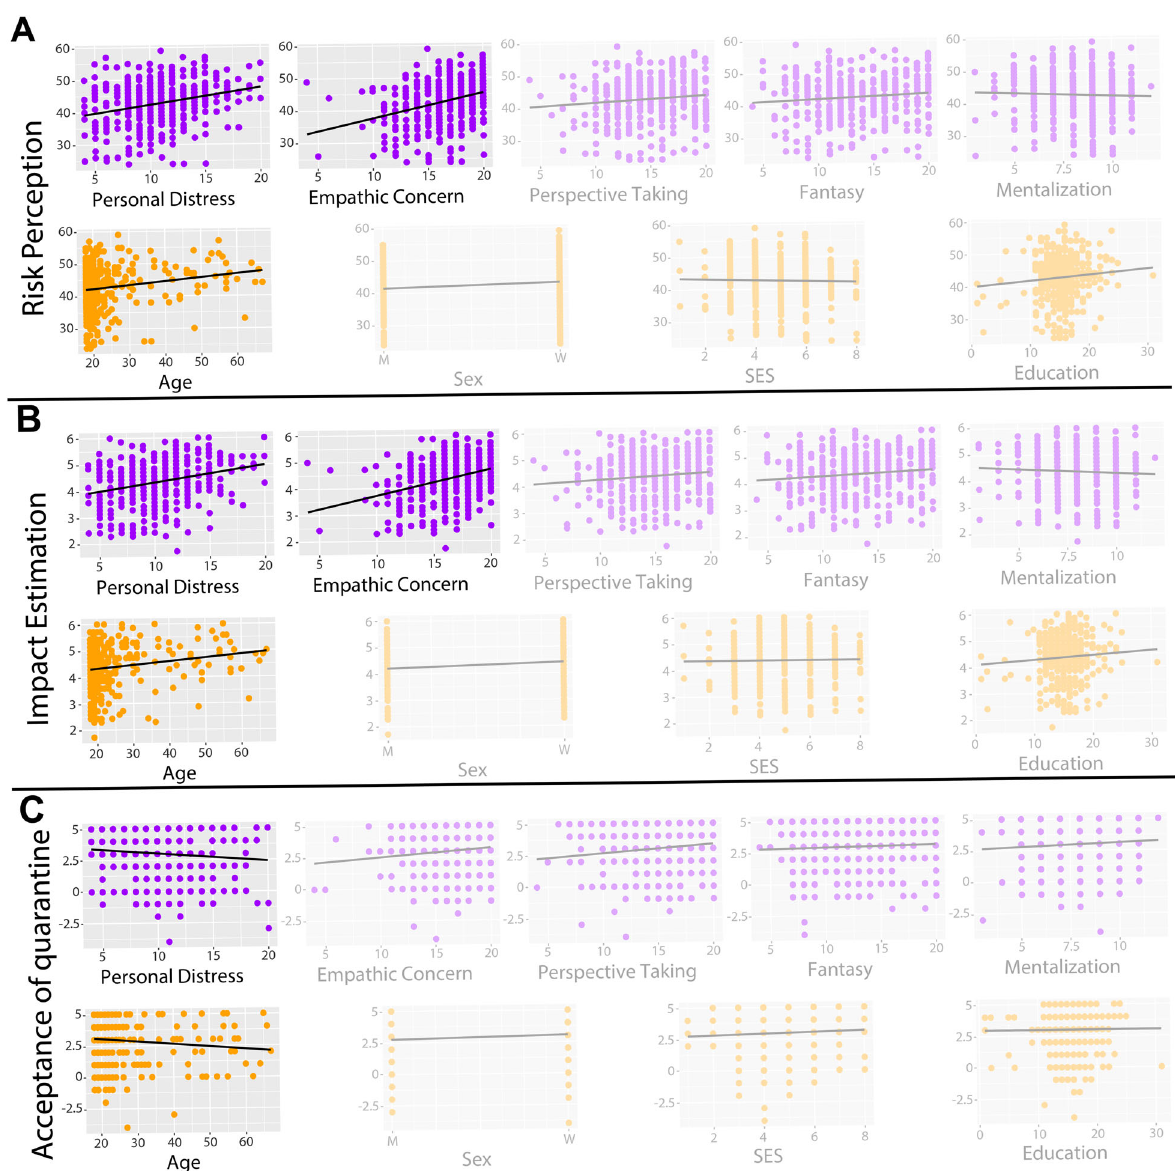
Fig. 1 Regression analyses result using social cognition measures as predictors. A Regression analysis using risk perception as the dependent variable. The dependent variable was explained by personal distress, empathic concern, and age. B Regression analysis using impact estimation as the dependent variable. This variable was predicted by personal distress, empathic concern, and age. C Regression analysis using the acceptance of quarantine as the dependent variable. This variable was predicted by personal distress, SES, and age. The non-signi fi cant variables were shaded across panels. SES socioeconomic